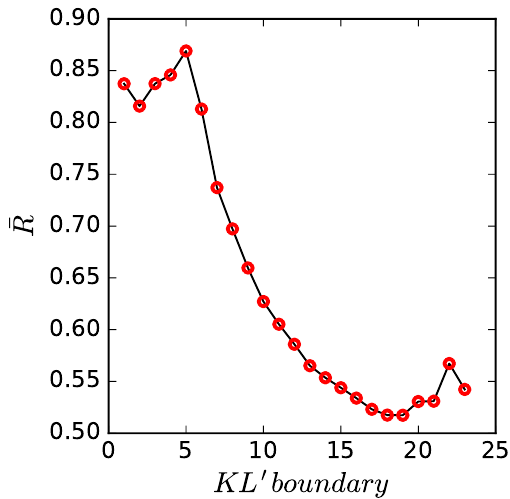
Figure 5. Mean ratio of identical topics of each KL (cid:48) group.